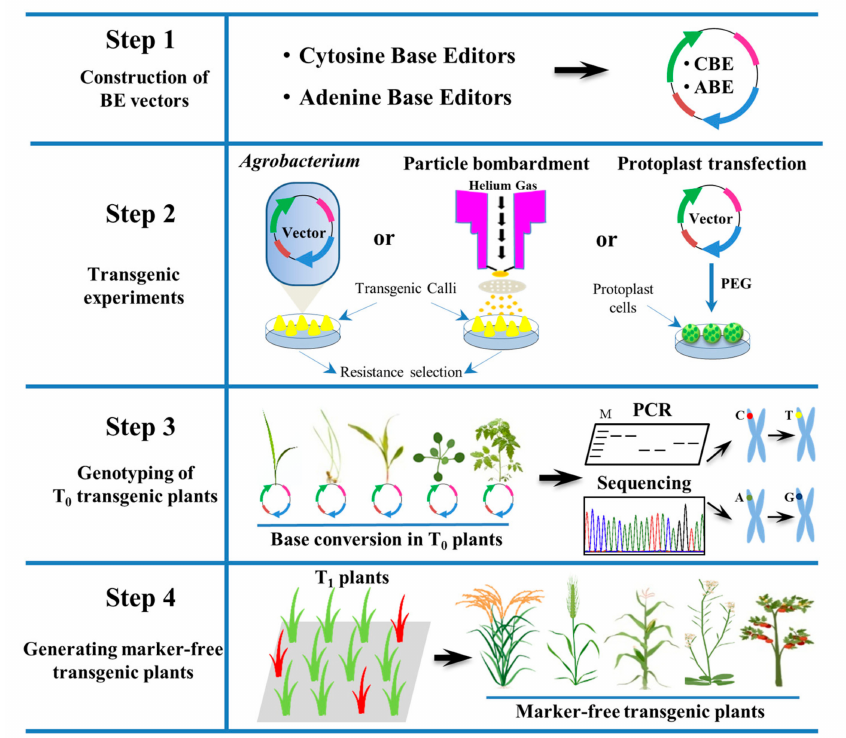
Figure 3. General steps of base editing . Steps of base editing tools: Construction of vectors, transformation, and mutants screening. According to Mendelian segregation laws, 25% plants will be marker-free transgenic plants in T 1 generation. Base editing successfully improves di ff erent traits of rice, wheat, maize, Arabidopsis , tomato and other